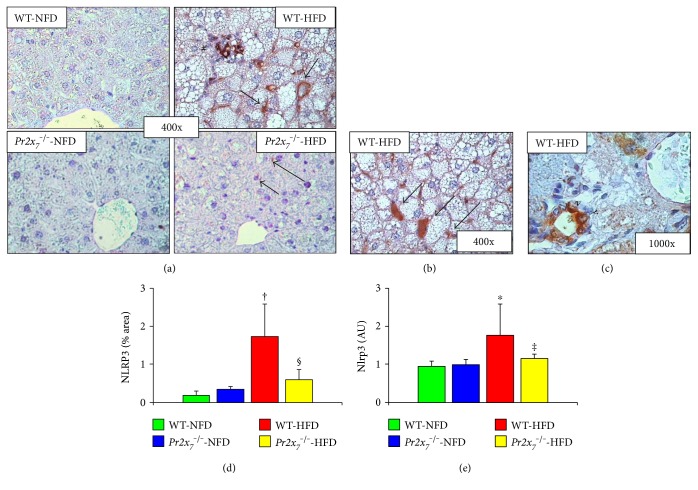
Hepatic NLRP3 expression. Immunohistochemistry for NLRP3 in liver sections from representative animals ((a) original magnification 400x, additional staining pattern features in HFD-fed WT mice in (b) original magnification 400x, and (c) original magnification 1000x oil immersion) and quantification of liver NLRP3 protein content (d) and Nlrp3 mRNA expression (e) in NFD- and HFD-fed WT mice and P2x7r−/− mice (mean ± SD; n = 4–6 per group). # = inflammatory cell infiltrate around degenerating hepatocytes; → = sinusoidal lining cells, especially in dilated sinusoidal spaces; > = bile duct epithelilal cells. ∗P < 0.001 or †P < 0.01 versus the corresponding NFD-fed mice; ‡P < 0.001 or §P < 0.05 versus WT mice. NLRP3 = nucleotide-binding and oligomerization domain (NOD), leucine-rich repeat and pyrin domain containing 3; Nlrp3 = NLRP3 gene; NFD = normal-fat diet; HFD = high-fat diet; WT = wild type; P2x7r−/− = knockout for purinergic receptor 2X7 gene.